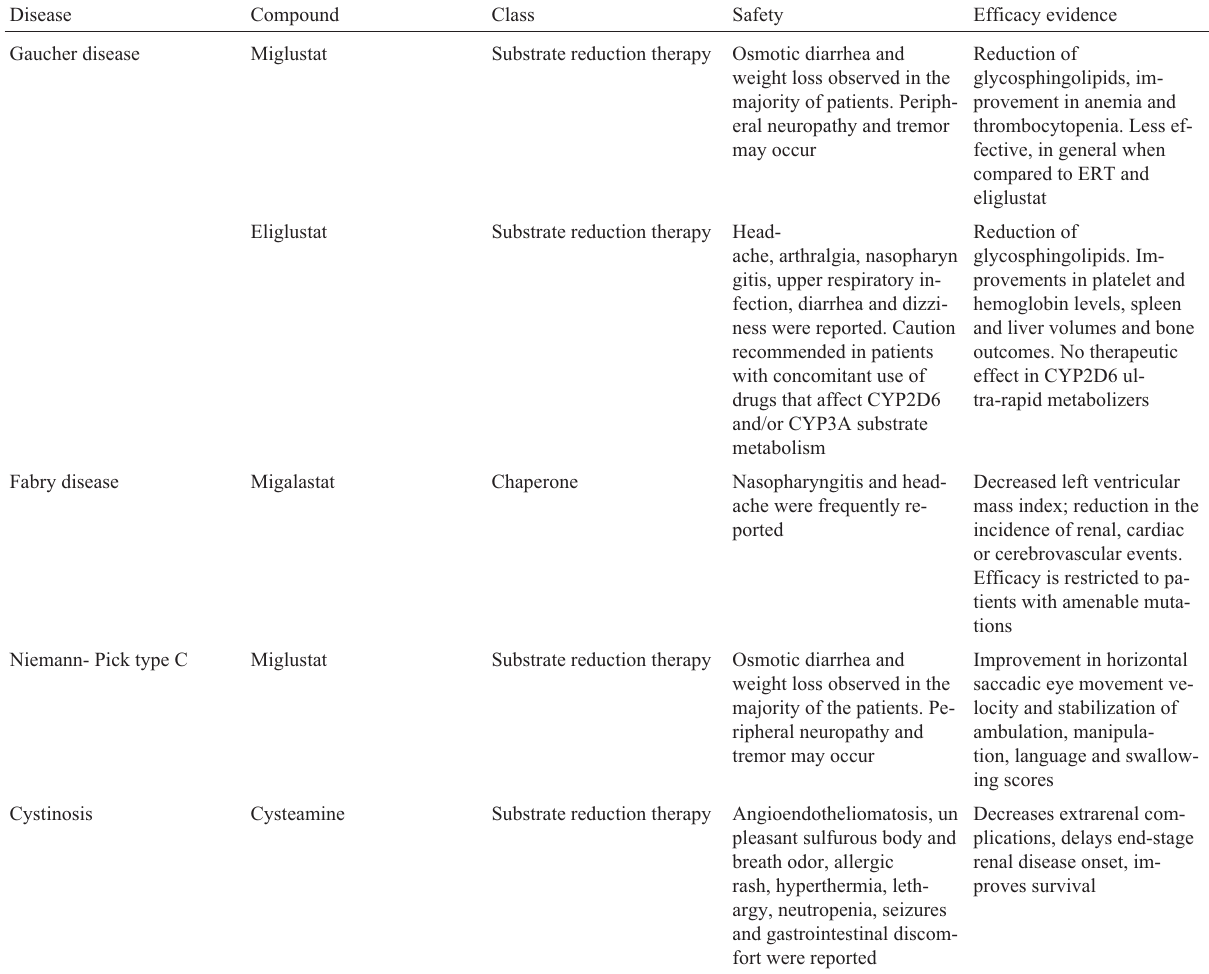
Table 4 - Approved small molecule-based therapies for lysosomal